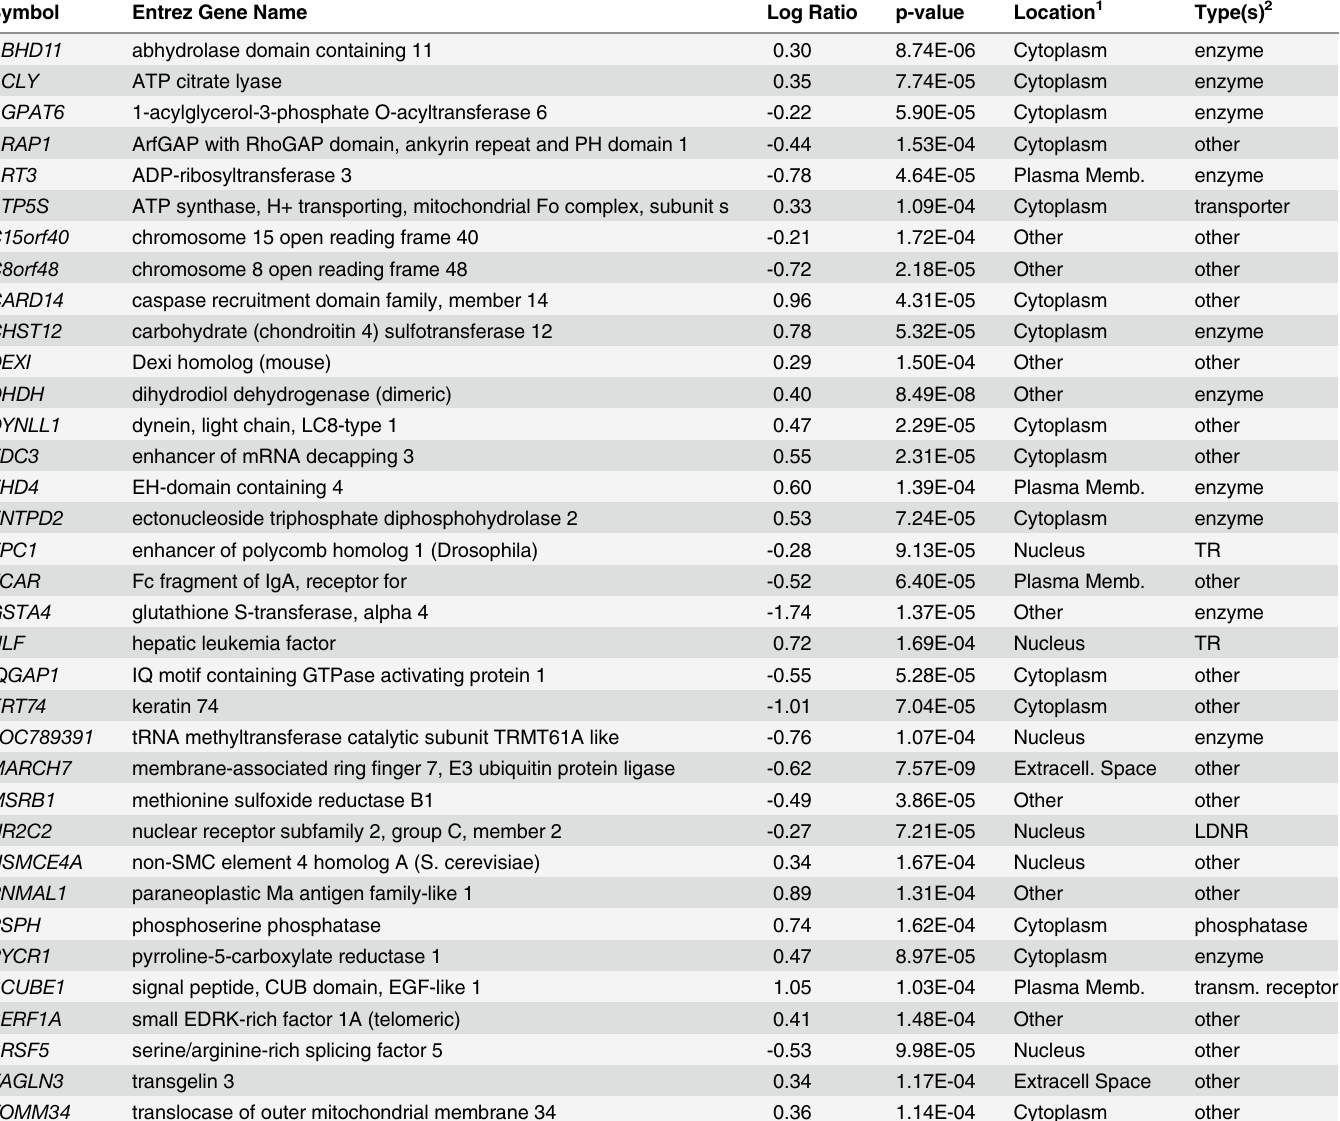
Table 3. Symbol, entrez gene ID, log ratio expression value [low plane of nutrition (LPN) vs. medium plane of nutrition (MPN], type of molecule and localization in the cell for the 35 differentially expressed genes affected by cow plane of